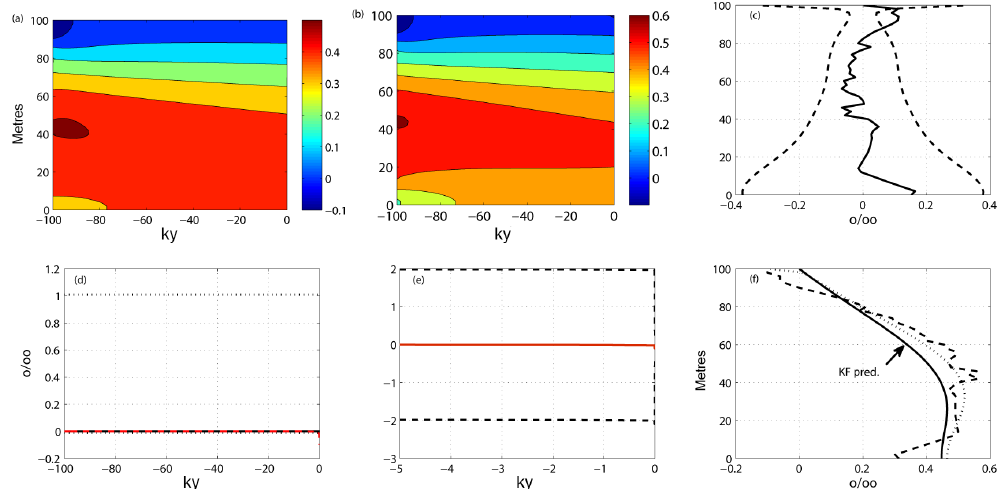
Figure 13. Core 1093 with a quasi-periodic initial condition, a flat prior, and terminal uncertainties forcing solution to the δ 18 O w at depth. Total control is flat, until the very